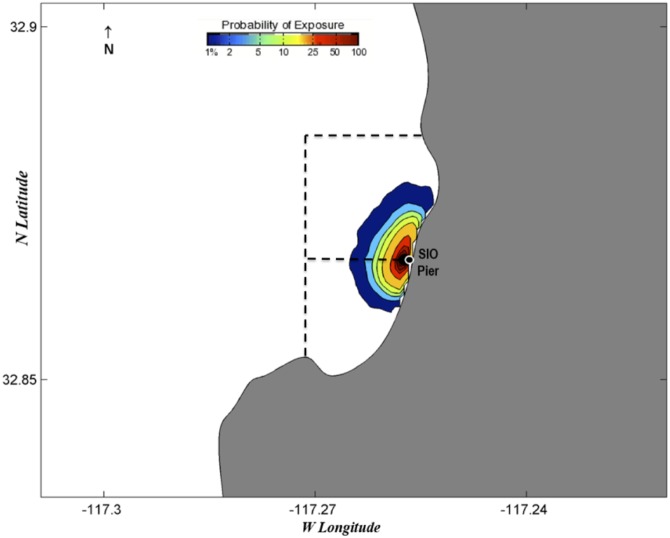
Probability map of predicted fish egg dispersal prior to collection: February 1–4, 2014.Dotted lines depict the boundaries of the MPAs: the San Diego-Scripps SMCA to the north and the Matlahuayl SMR to the south.